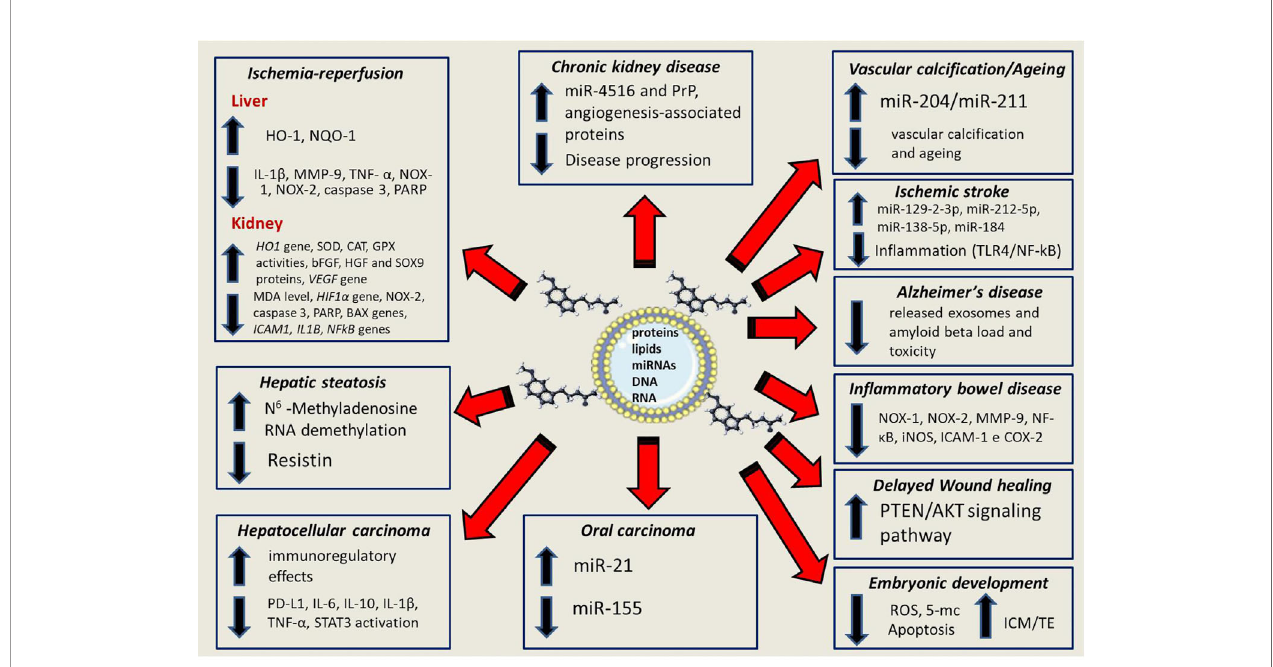
FIGURE 2 | The up- and down-regualtion of multiple process that involve the partnership between melatonin and exosomes; these include signaling pathways for in fl ammation, oxidative stress and apoptotic events as well as well as gene. microRNAs, protein and transcription factors. An in-depth knowledge of the control of the synergistic effects between melatonin and exosomes offers a valuable therapeutic promise for the treatment of several